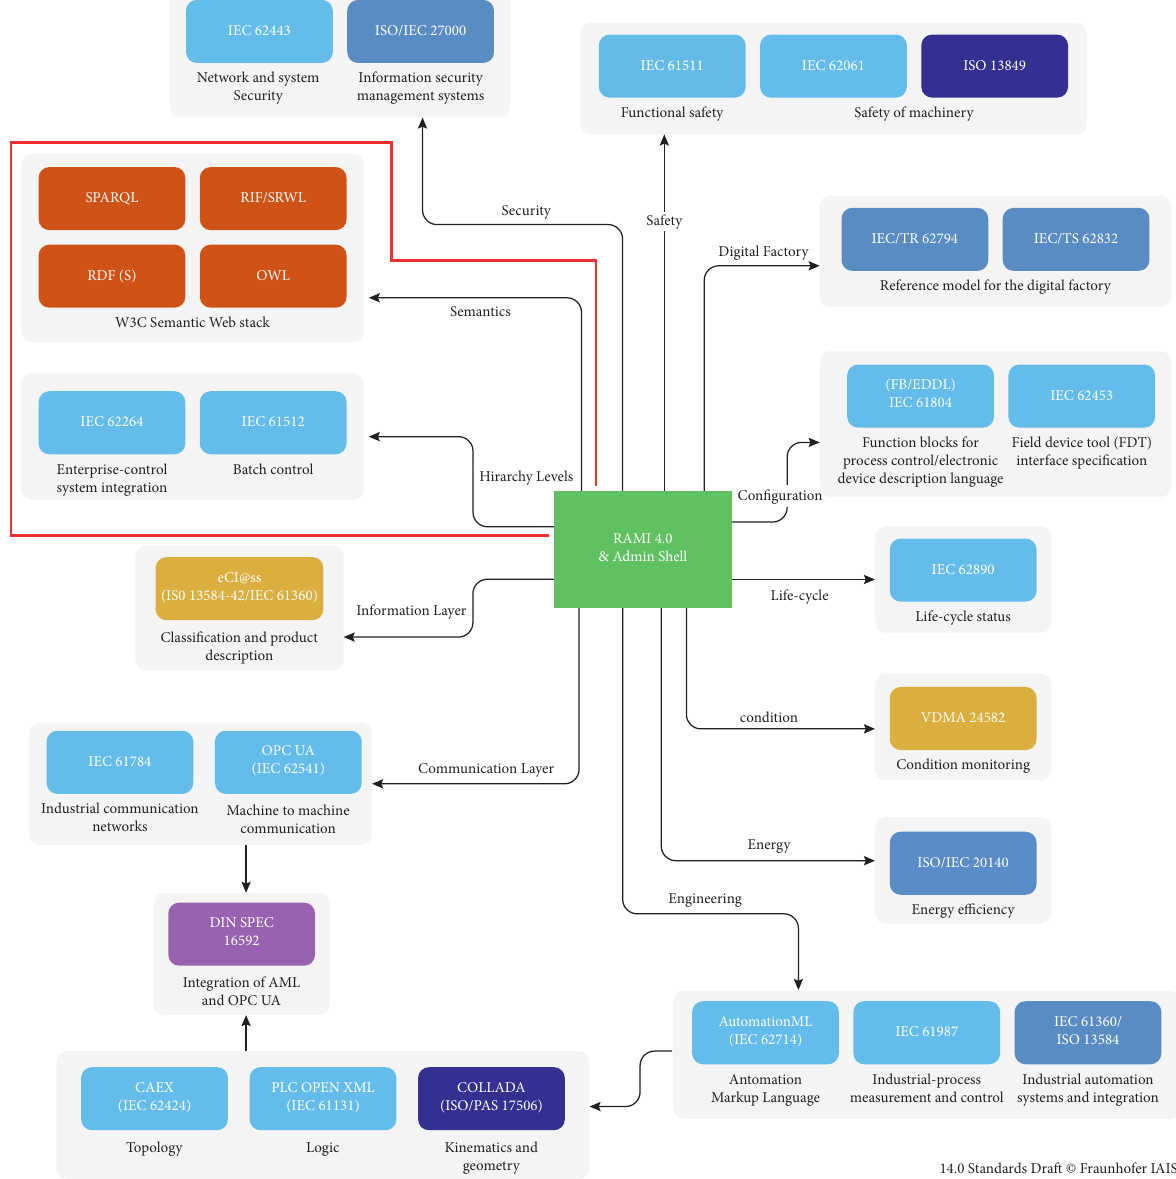
Figure 9: Industry 4.0 standards by means of semantic technologies